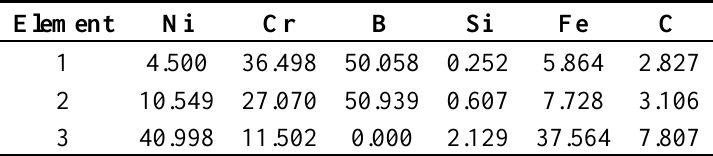
Figure 4. SEM ( a ) and backscatter electron (BSE) ( b ) images of the herringbone structure of sample A. Table 3. The electron probe microanalysis (EPMA) results of points on Figure 4b. Composition is shown in